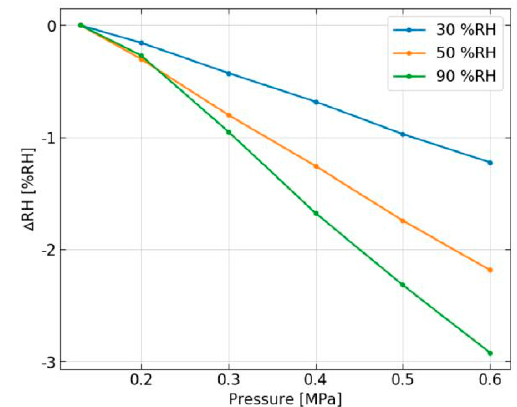
Figure 3. Measurement of the pressure dependence at different relative humidity